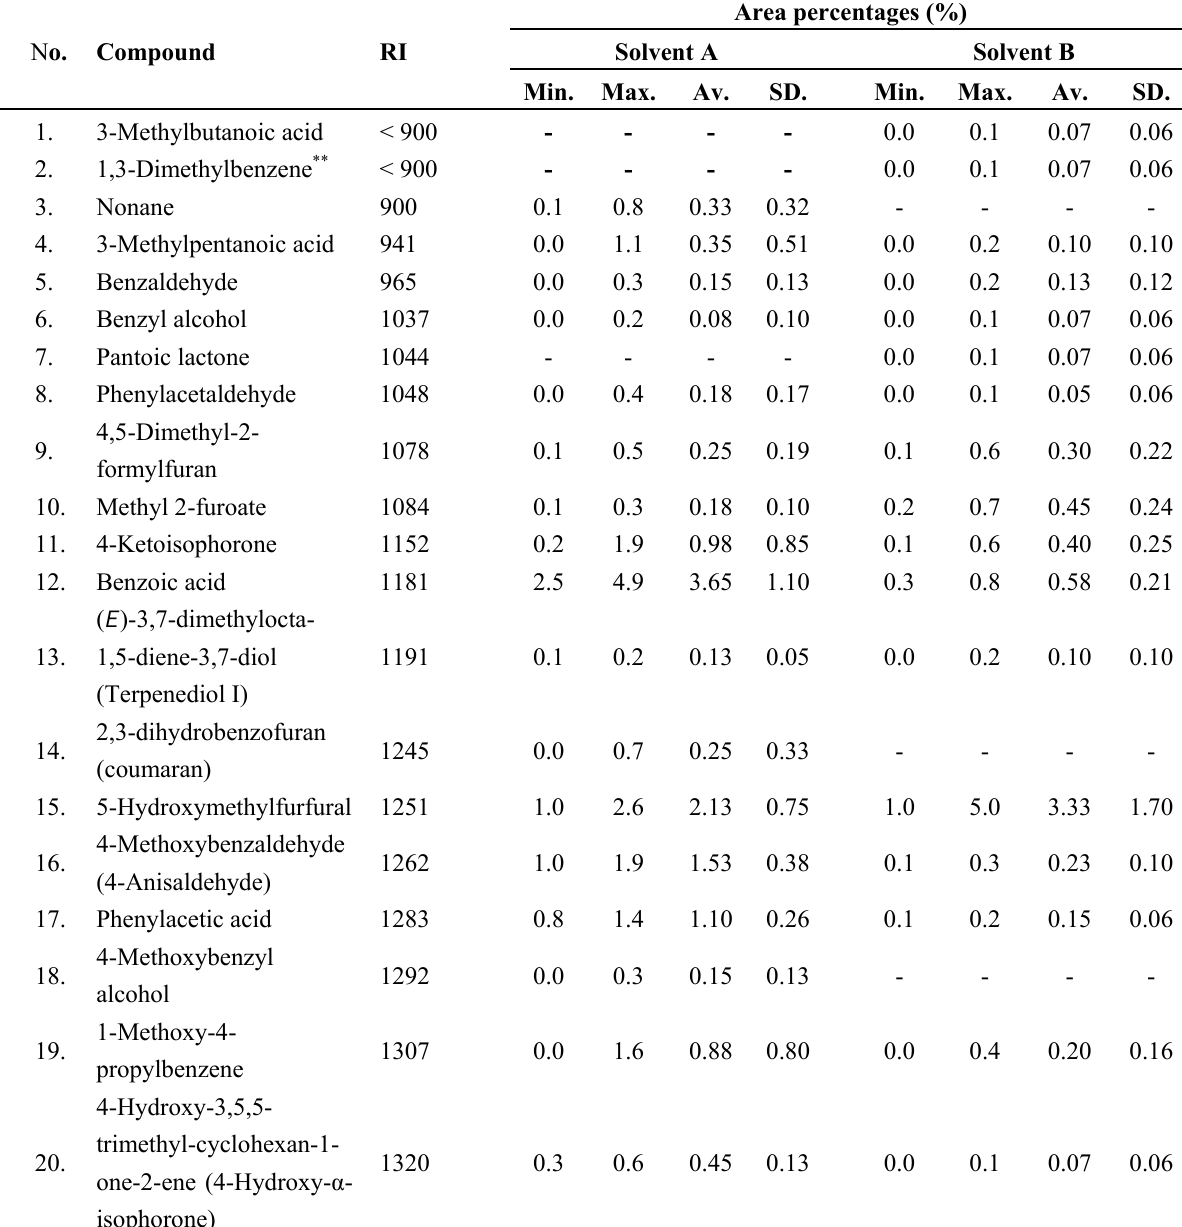
Table 2. Prunus mahaleb L. honey volatile organic composition obtained by USE with two solvents followed by GC and GC-MS